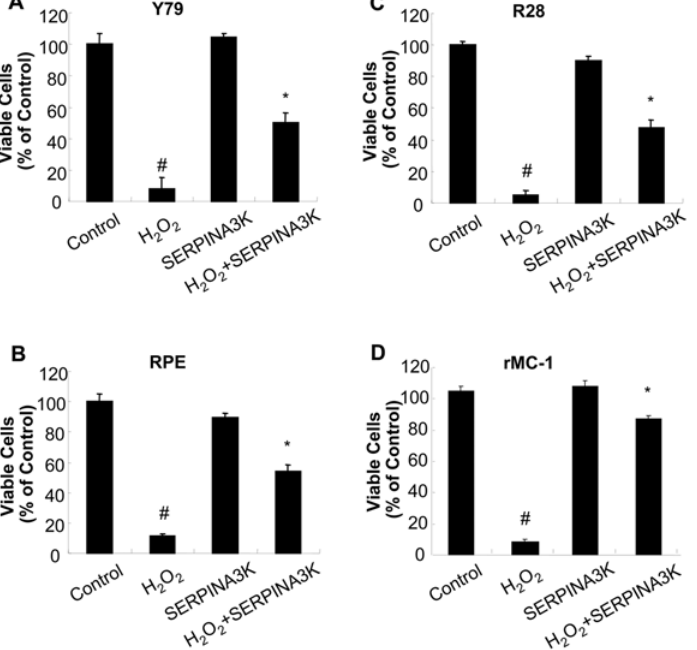
Figure 1. Protective effects of SERPINA3K in retinal cells. Y79 ( A ), R28 ( B ), RPE ( C ) and rMC-1 cells ( D ) were exposed to 400 m M H 2 O 2 in the presence of 1 m M SERPINA3K or BSA for 8 h, or incubated with 1 m M SERPINA3K alone for 8 h. Viable cells were quantified by MTT assay (mean 6 SEM, n=3). * P , 0.01, versus the H 2 O 2 treated cells. # P , 0.01, versus the control cells.